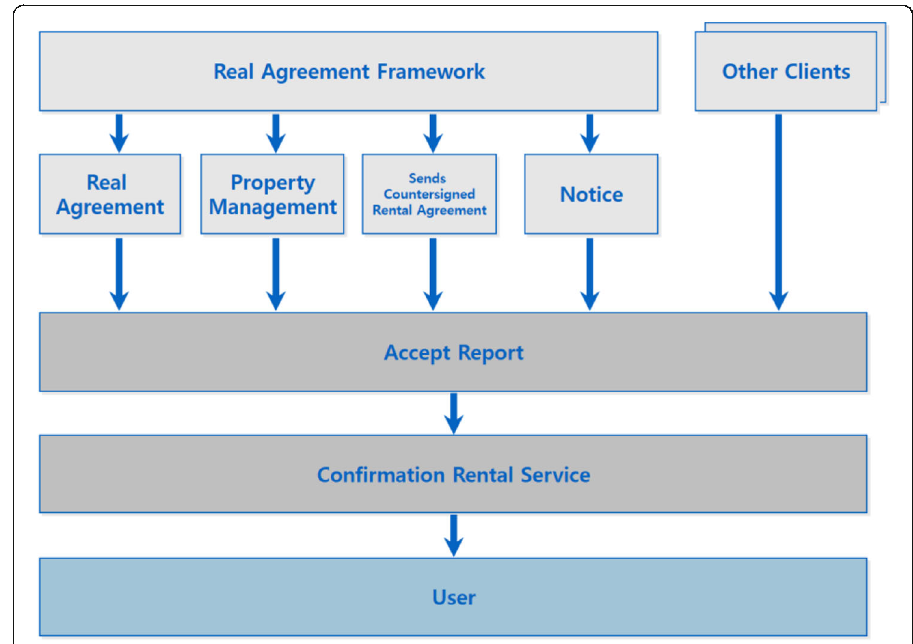
Fig. 10 Overview of the current